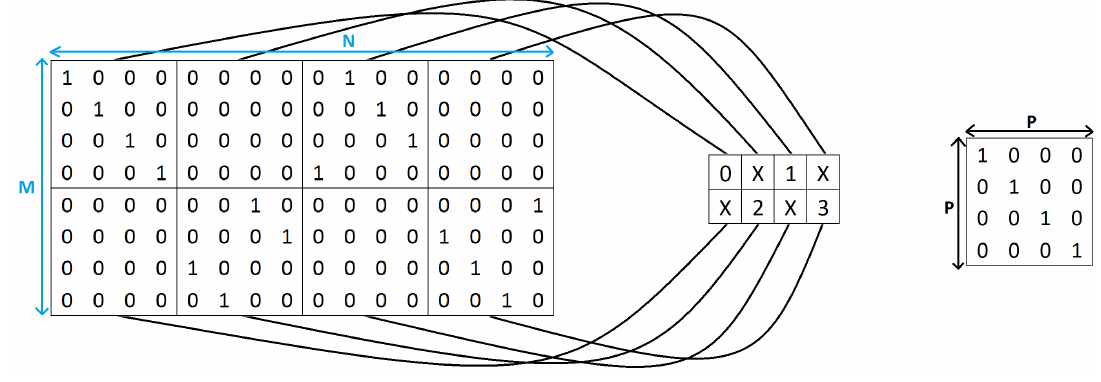
Figure 1. An example matrix H of the QC type code.